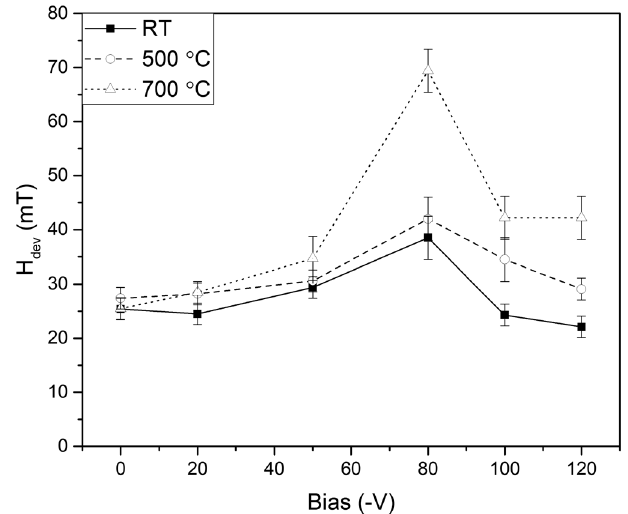
FIG. 2. Example of a raw dc hysteresis curve. The film was deposited at 700 °C with a − 80 V biased substrate. The dashed lines denote either H